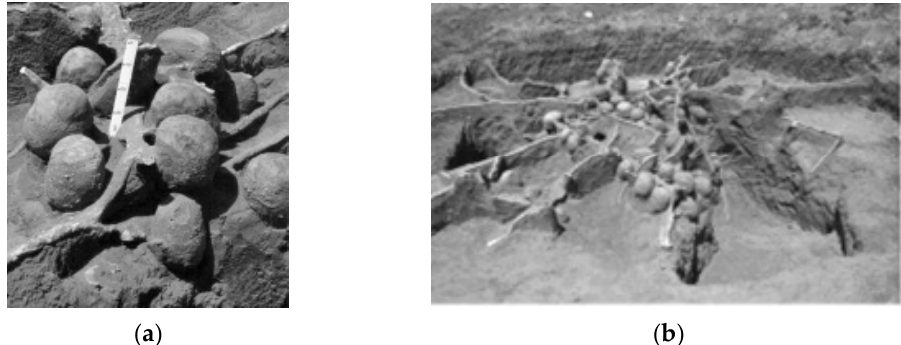
Figure 4. Atta bisphaerica nest: ( a ) chamber and tunnel details and ( b ) radial distribution of foraging tunnels.